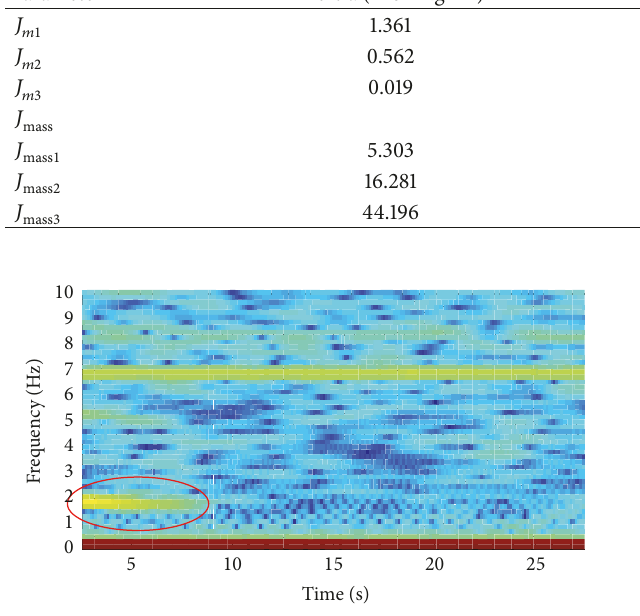
Figure 7: Time-frequency spectrum of the drive-side velocity using the STFT.